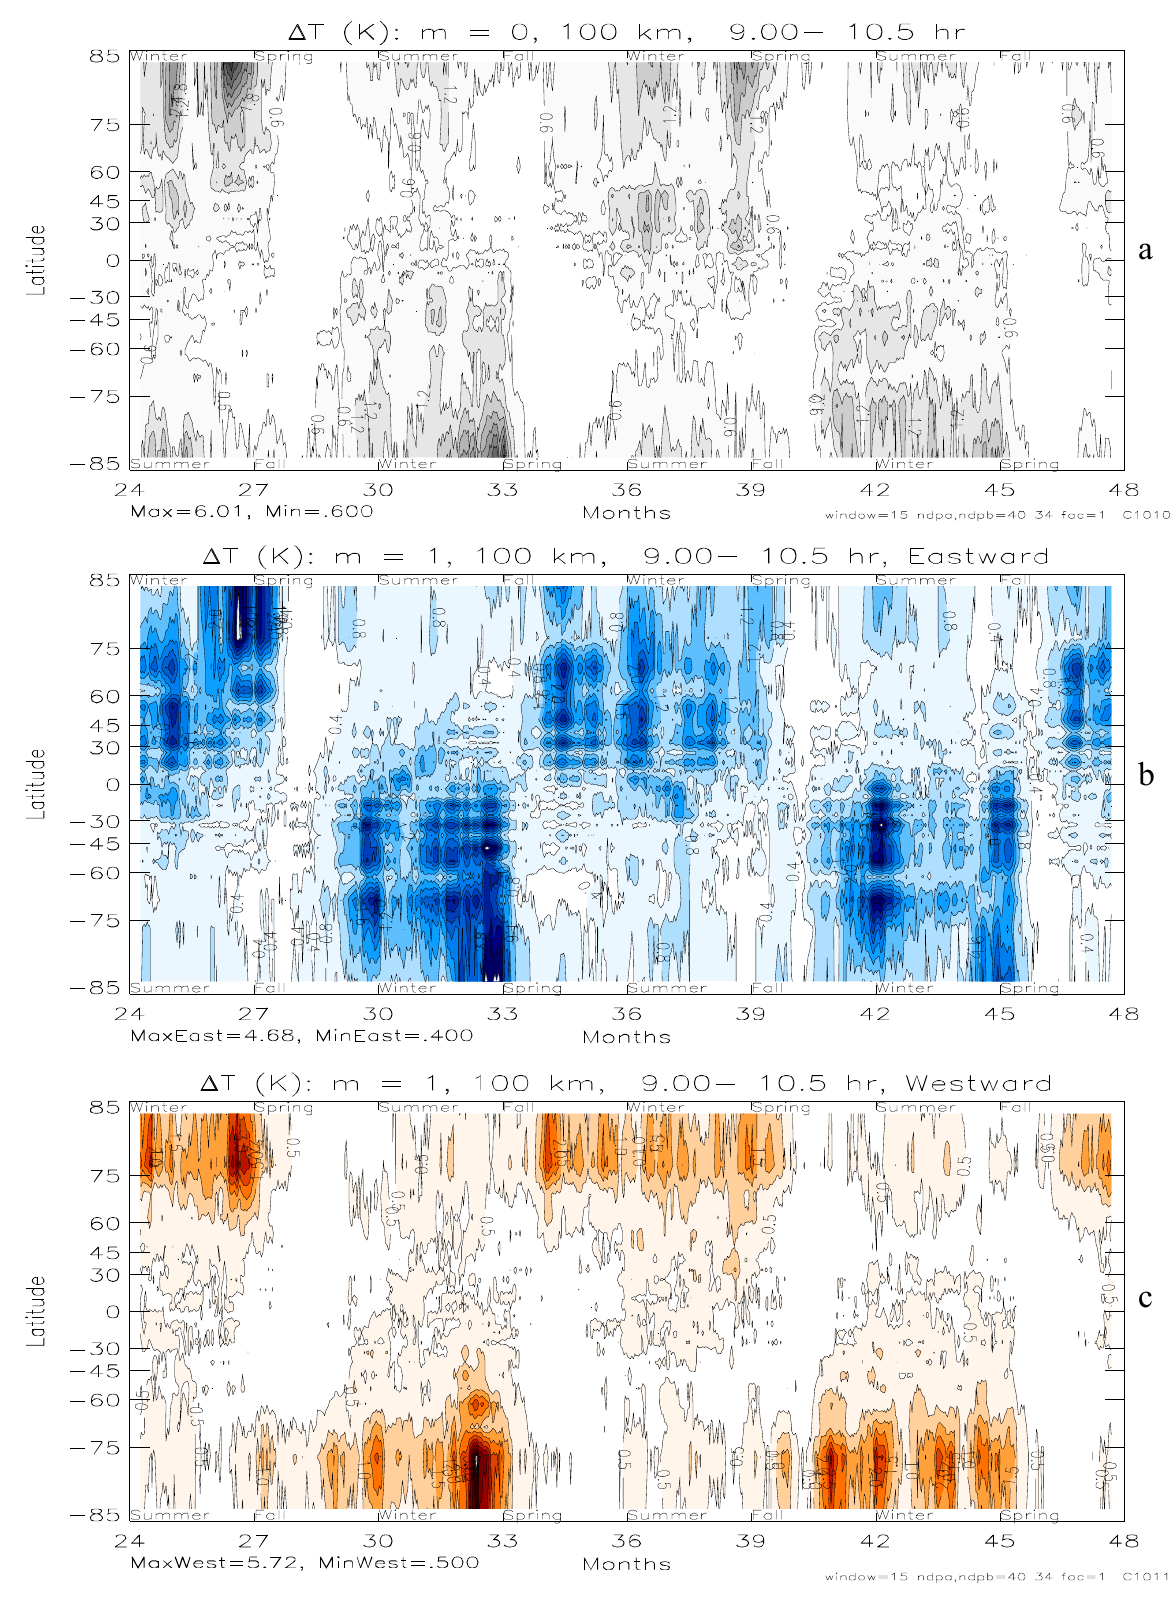
Fig. 9. Like Fig. 8 but for temperature variations with maximum amplitudes (K): 6 ( a ) , 4.7 ( b ) , 5.7 ( c )